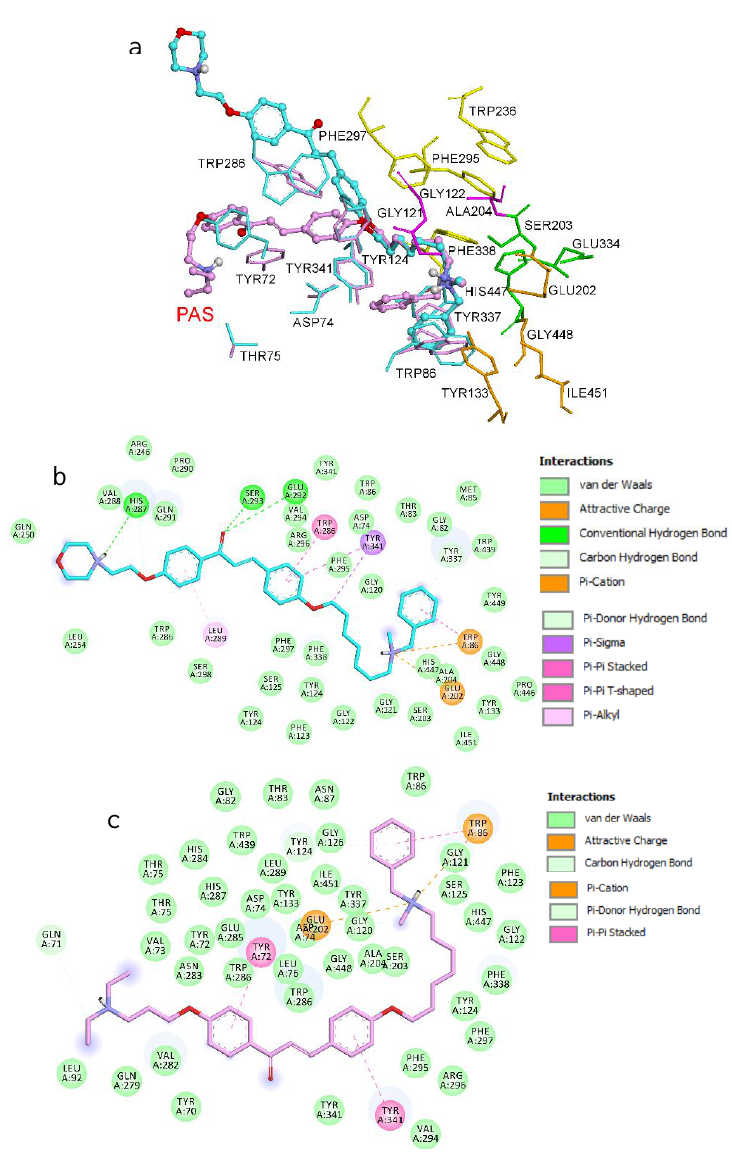
Figure 2. Docked pose of inhibitors 4 and 6 at the active site of h AChE. ( a ) Compounds 4 and 6 are rendered as ball and sticks ( 4 , carbon atoms in pink; 6 , carbon atoms in blue) and the side chain conformations of the mobile residues are illustrated in pink and blue, respectively. The catalytic triad (CT) is colored in green, the oxyanion hole (OH) in magenta, the anionic sub-site (AS) in orange, except Trp86, the acyl binding pocket (ABP) in yellow and PAS in light pink and blue; ( b ) 2D-representation of interactions established by 4 with h AChE; ( c ) 2D-representation of interactions established by 6 with h AChE.